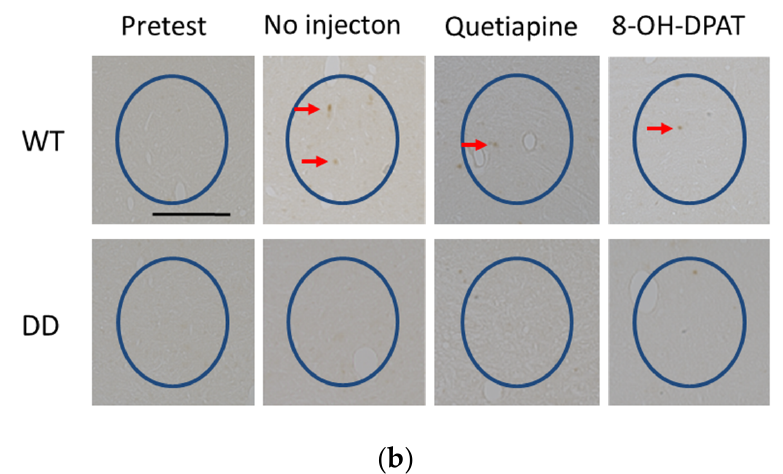
Figure 6. Neuronal activity after quetiapine and 8-OH-DPAT administration in the rostral linear nucleus in DD mice. ( a ) Number of Fos-positive cells per 0.04 mm 2 of the rostral linear nucleus before and 1 h after quetiapine and 8-OH-DPAT administration in WT and DD mice. * p < 0.05, compared with no injection (Scheff é test); ## p < 0.01, compared with WT (Scheff é test). The data are expressed as mean ± SEM. ( b ) Representative immunohistochemical images before and 1 h after quetiapine and 8-OH-DPAT administration in WT and DD mice. Scale bar = 100 µ m. Fos-positive cells are indicated by arrows. The blue line depicts the shape of the RLi. 8-OH-DPAT, 8-hydroxy-2-dipropylaminotetralin hydrobromide; WT, wildtype mice; DD, dopamine-deficient mice.